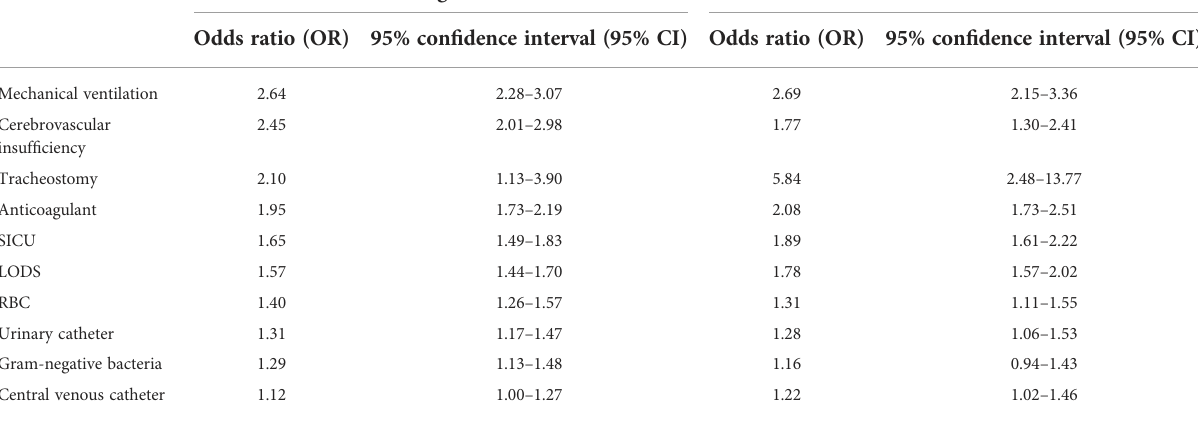
TABLE 4 Multivariate logistic analysis of risk factors for ICU-acquired infection in patients with sepsis. Covariates Training cohort Validation